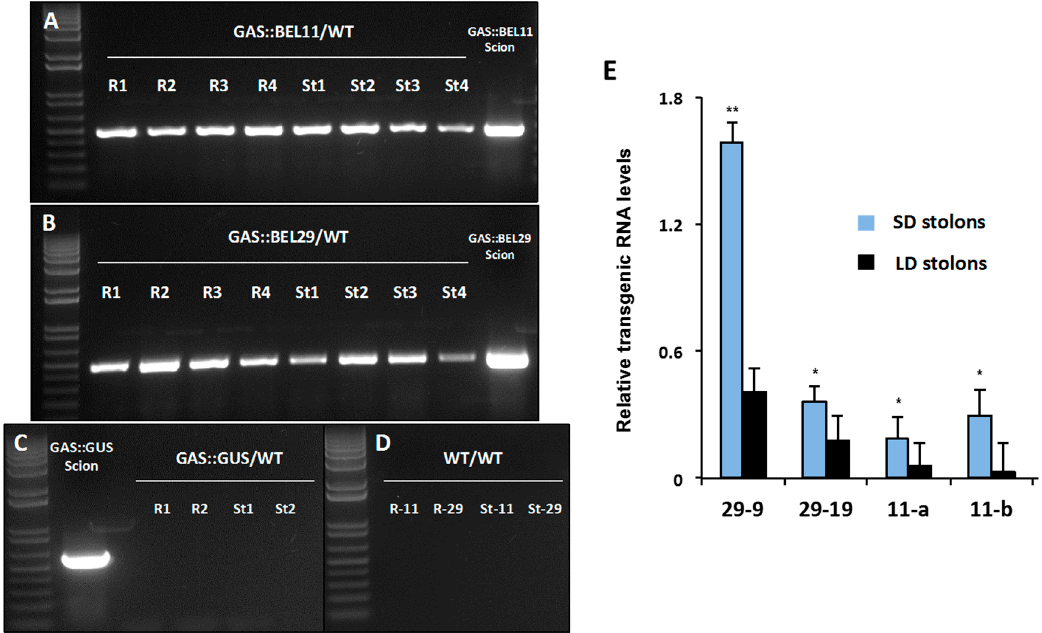
Figure 4. Movement of transgenic StBEL11 ( A ) and -29 ( B ) mRNA across heterografts of soil-grown plants. Heterografts were performed with four replicates of GAS::BEL11 (line 11b), GAS::BEL29 (line 29-9) and GAS::GUS scions on non-transformed wild-type S. tuberosum ssp. andigena line 7540 (WT) stocks. Culture conditions and one-step RT-PCR using transgenic-specific primers were previously described [10]. All PCR products detected in scion (positive control) and stock (test for movement) RNA samples represent transgenic RNA. RNA from scion leaf samples was used as a positive control (scion samples). Heterografts are designated R1-4 (root stock RNA) and St1-4 (stolon stock RNA). Negative controls for movement of GUS ( C ) and PCR of WT ( D ) RNA are included. Photoperiod effect on the movement of transgenic StBEL29 and StBEL11 mRNA from leaves into stolons was assessed ( E ). Full-length transgenic RNA was driven by the leaf-specific GAS promoter of melon [46,49]. GAS::BEL11 and -29 plants were grown under either long-day (LD) or short-day (SD) conditions [10]. RT-qPCR with gene-specific primers was used to calculate the amount of transgenic RNA in stolons. Samples were measured in duplicate and normalized against StActin8 mRNA. The fold change in RNA levels was calculated as the 2 −ΔΔ Ct value relative to transgenic RNA (set at a value of 1.0) detected in the source leaf. Standard errors of the means of two biological replicates are shown with one or two asterisks indicating a significant difference ( p < 0.05 or p < 0.01, respectively). With permission of the publisher [10].